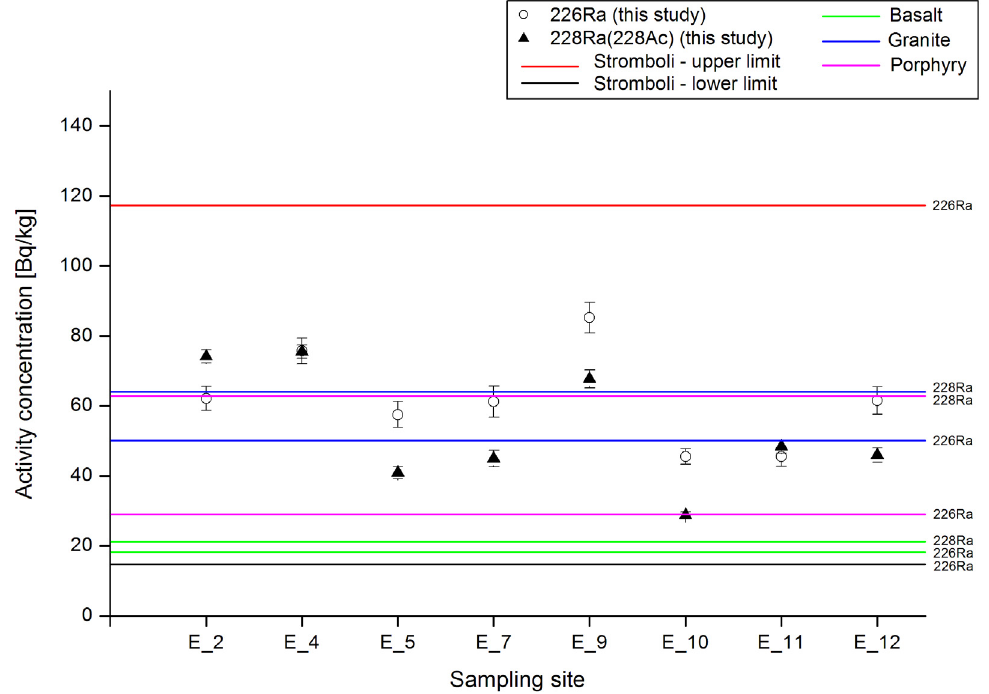
Figure 3. Activity concentrations of 226 Ra (open circles) and 228 Ra( 228 Ac) (filled triangles) in [Bq/kg] in the rocks/soil samples surrounding the water intakes sampled in this work. Activity values were obtained from c -spectrometry analyses. For comparison, the range of the re- sults for Stromboli is presented [Chiozzi et al. 2003], together with average values from other Italian magmatic rocks [ANPA 2000, ARPA Piemonte